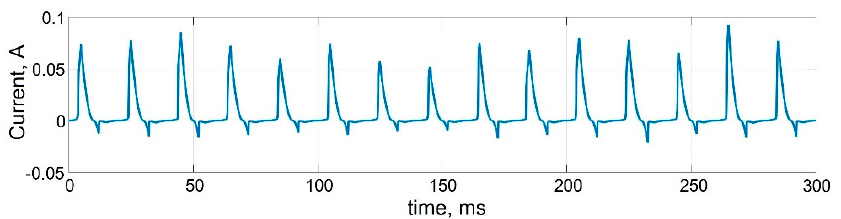
Figure 5. Transients of cyclic bipolar switching of memristive element.